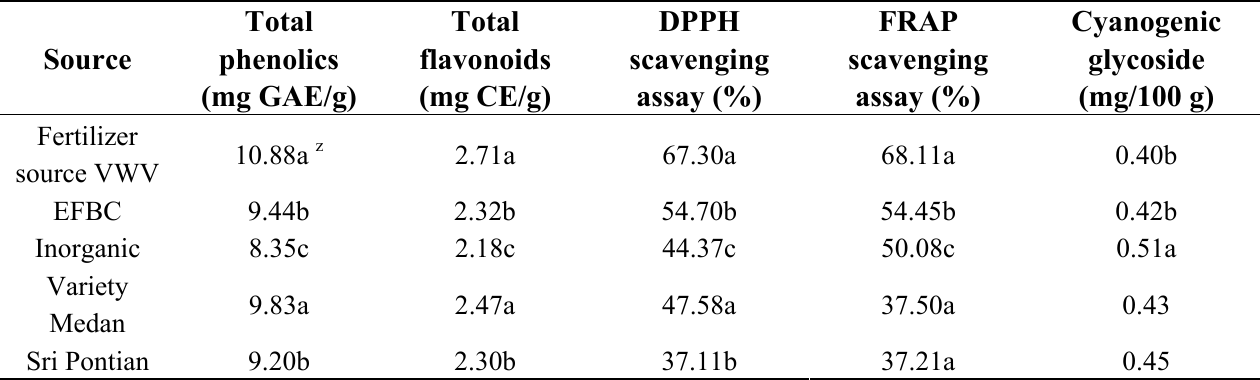
Table 2. Phytochemical compounds in tuber of cassava varieties as affected by fertilizer